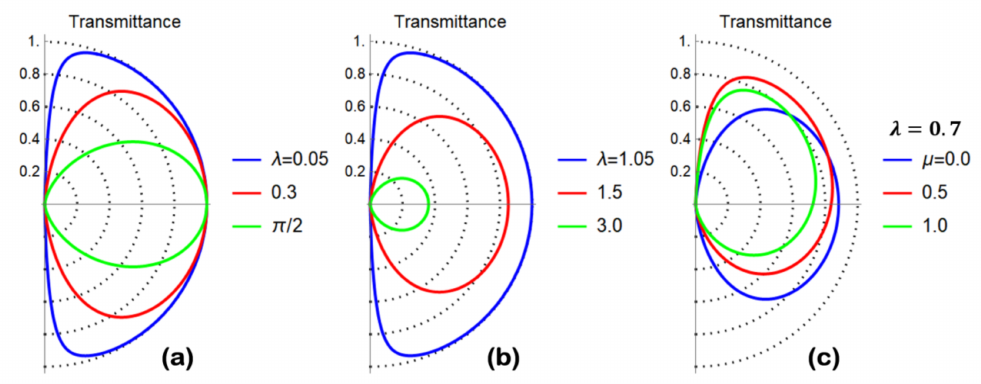
Figure 2. ( a ) Polar plot of the transmittance (transmission probability) |T ( φ ) | 2 versus the incidence angle φ computed according to Equation (32) and setting the model parameters as specified in the legend. The matching matrix that is used belongs to SU(2), and accordingly, full transmission is observed for φ = 0 incidence, with the latter result being insensitive to the parameter choice and reminiscent of the Klein tunneling phenomenon. ( b ) Polar plot of the transmittance (transmission probability) |T ( φ ) | 2 versus the incidence angle φ computed according to Equation (36) and setting the model parameters as specified in the legend. Diagonal SL ( 2, C ) matching matrix (see Equation (35)) has been used. A reduction of the transmittance is observed for arbitrary values of the incidence angle as the parameter λ is increased. ( c ) Polar plot of the transmittance (transmission probability) |T ( φ ) | 2 versus the incidence angle φ computed according to Equation (38) and setting the model parameters as specified in the legend. A non-diagonal SL ( 2, C ) matching matrix (see Equation (37)) has been used. An anisotropic reduction of the transmittance is observed for the arbitrary values of the incidence angle as the parameter µ is increased. Preferential transport directions are